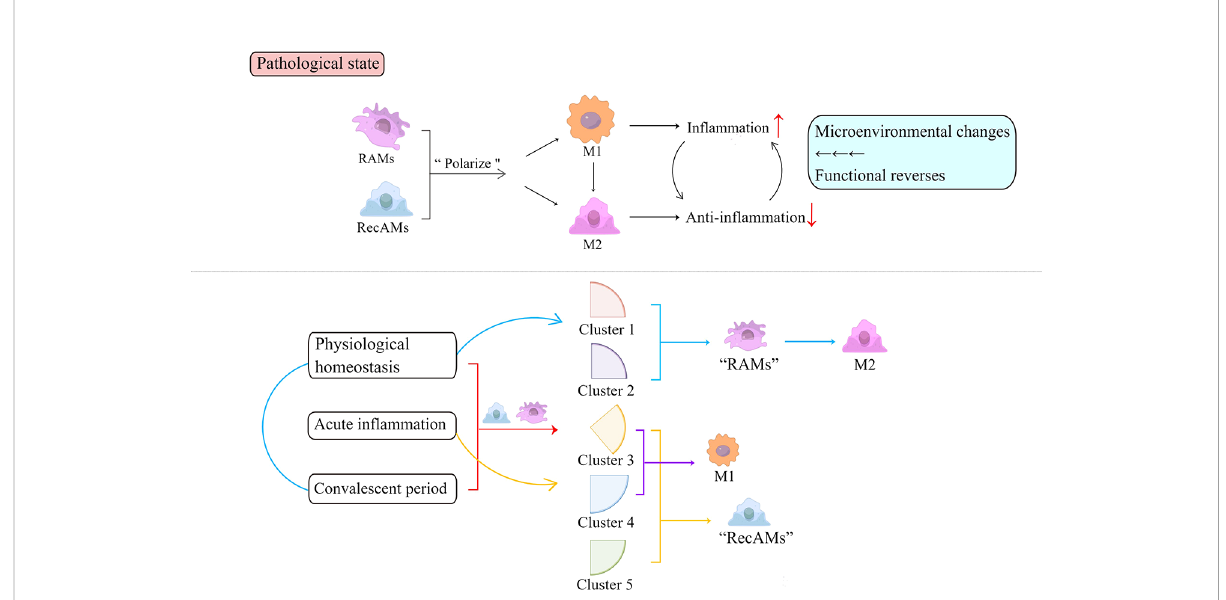
FIGURE 3 In fl ammation activates the polarization of AMs. Depending on functions, polarized AMs are roughly divided into pro-in fl ammatory M1 and anti- in fl ammatory M2. Based on their single-cell RNA sequencing analysis, AMs can be identi fi ed as fi ve clusters at three time points throughout the in fl ammatory phase, indicated by the red square bracket and arrow. Clusters 1 and 2 contain cells with RAM markers that are present during both homeostasis and in fl ammation and are dominated by M2-like functions in the homeostasis and convalescent phase, marked by blue parentheses and arrows. Clusters 3, 4, and 5 exist only during in fl ammation and are predominantly characteristic of RecAMs (herein noted by yellow arrows and square brackets). Among them, clusters 3 and 4 are dominated by M1 gene expression (herein annotated by the purple square bracket and arrow). Cluster 5 has a relatively low expression of both M1 and M2 genes. Each cluster has corresponding cellular characteristics that re fl ect the cell-derived sources and exhibits different functions. RAMs, resident airspace macrophages; RecAMs, recruited airspace macrophages; M,